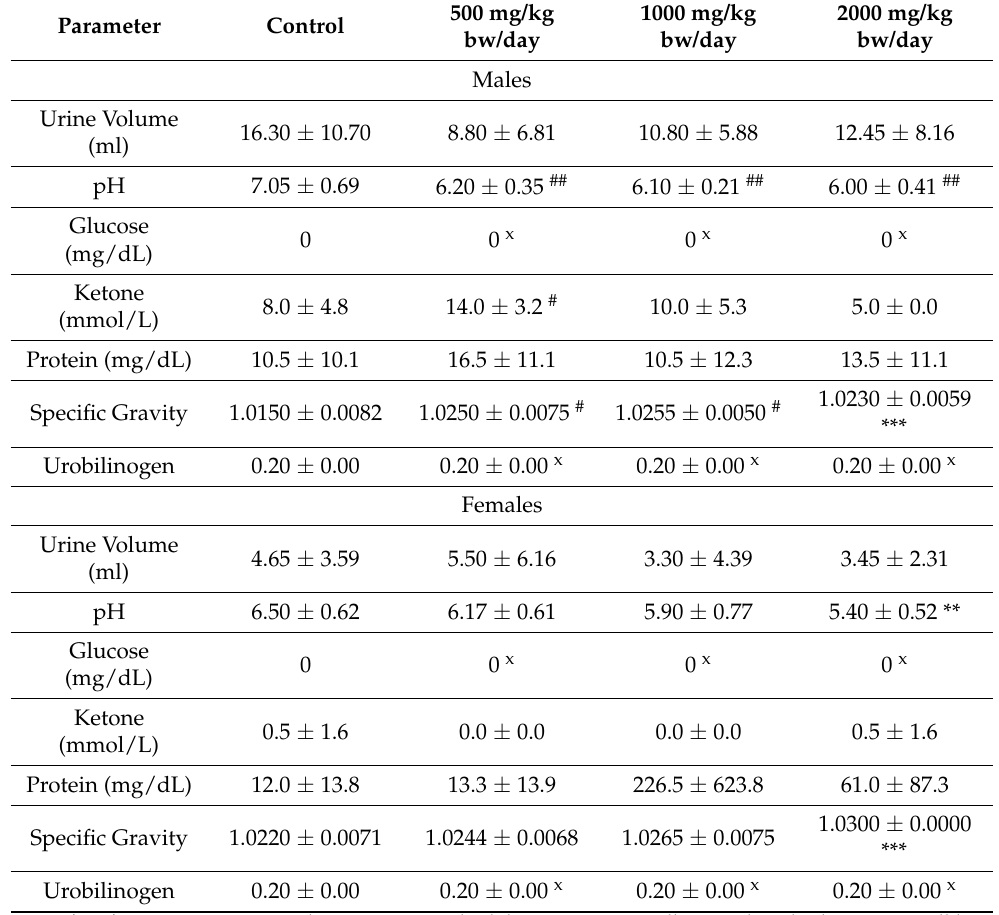
Table 6. Urinalysis data for the 28-day repeat dose oral toxicity study with